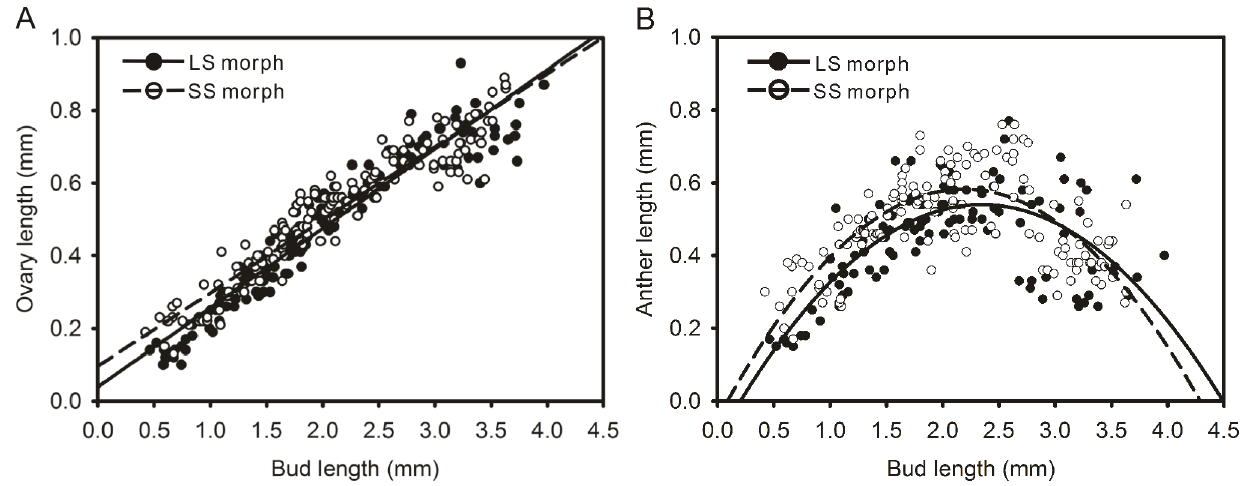
Figure 3. The development of ovaries and anthers in two morphs of Polygonumjucundum . A, Ovary; B, Anther. Regression lines were fitted separately to the data for each floral